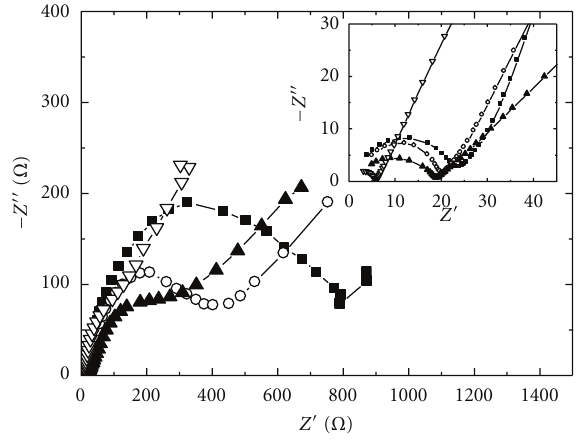
Figure 10: Bode diagram showing the variation of the modulus of the impedance | Z ∗ | (lines) and the out-of-phase angle ( φ = tan − 1 / ( Z (cid:8)(cid:8) /Z (cid:8) ) (symbols) with the frequency at 20 ◦ C (solid line and filled circles), 40 ◦ C (dash line and filled squares), 60 ◦ C (dot line and open triangles), and 80 ◦ C (dash dot line and filled circles) for the C5FNDIHS membrane in the acid form equilibrated with distilled